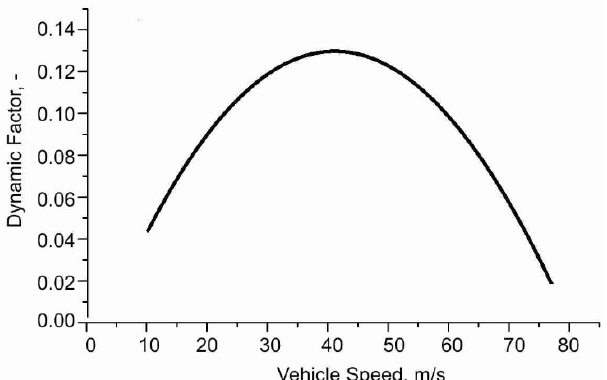
Figure 8 – Dynamic factor for 100% fuel injection in the engine and transmission ratio of the planetary gearbox equal 1